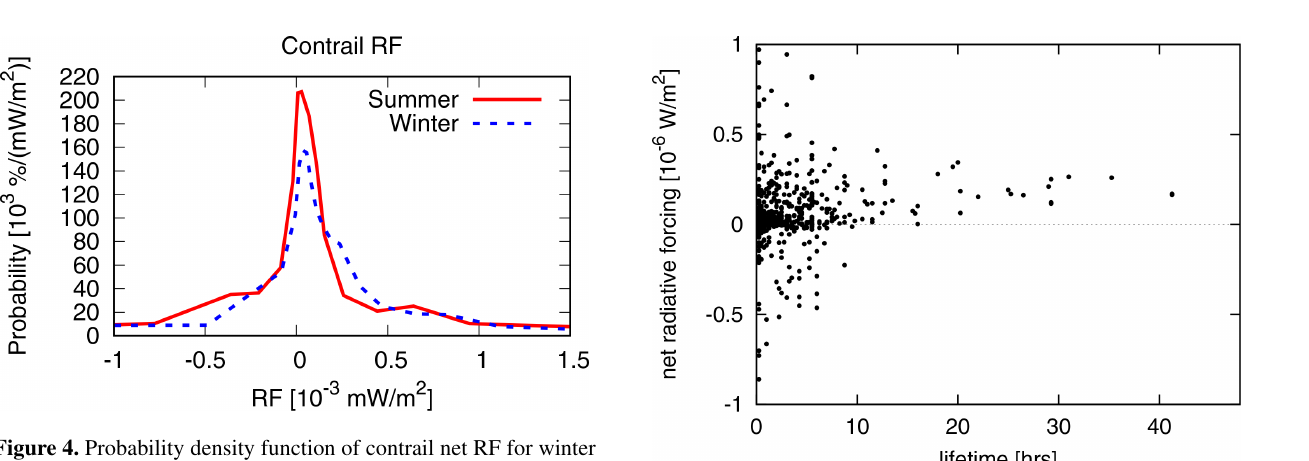
Figure 3. Potential contrail coverage at the time step of emission release (12:00UTC) in percent (%) at 250hPa for eight representative weather situations.